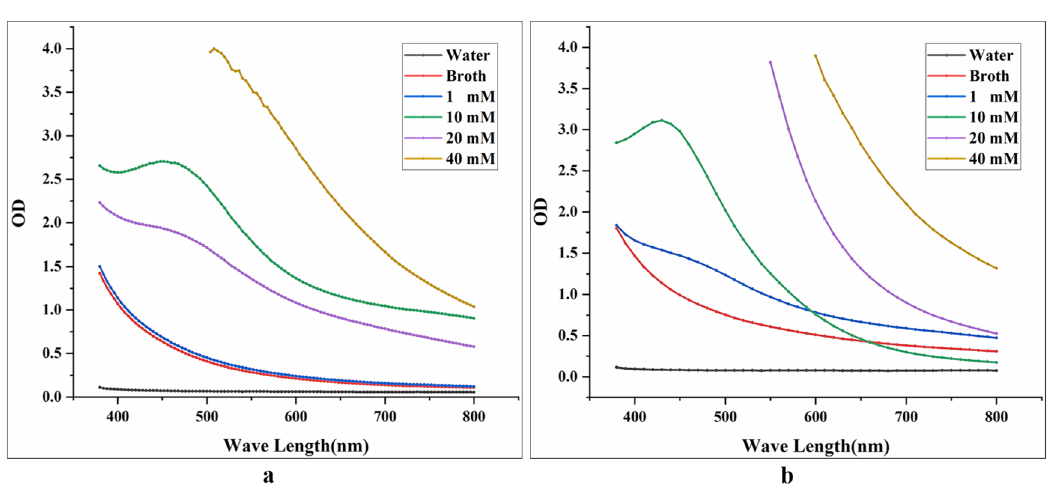
Figure 4. Absorption spectra of solutions with different concentrations of Ag + (1 mM, 10 mM, 20 mM and 40 mM) ; water and broth of yeasts as control group, this reaction happens in a conical flask wrapped with tinfoil at 28 °C for 4 d [( a ) solutions are treated with HX-YS; ( b ) solutions are treated with